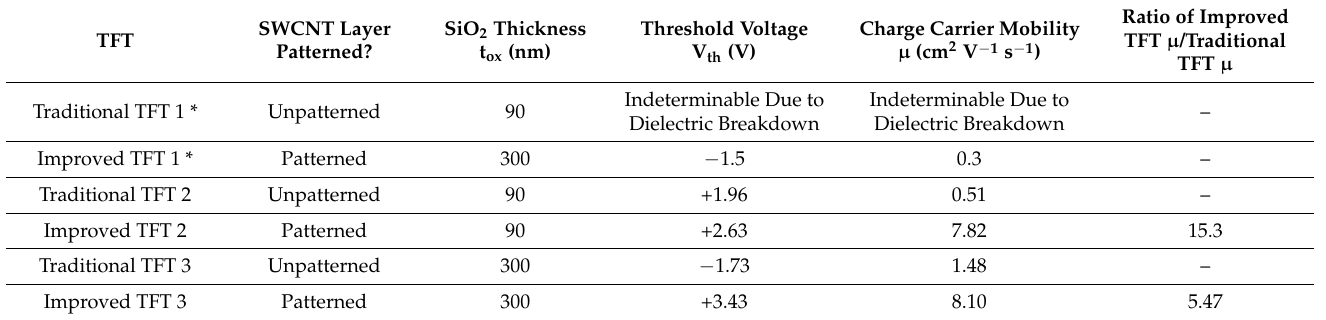
Table 3. The threshold voltage and charge carrier mobility of each